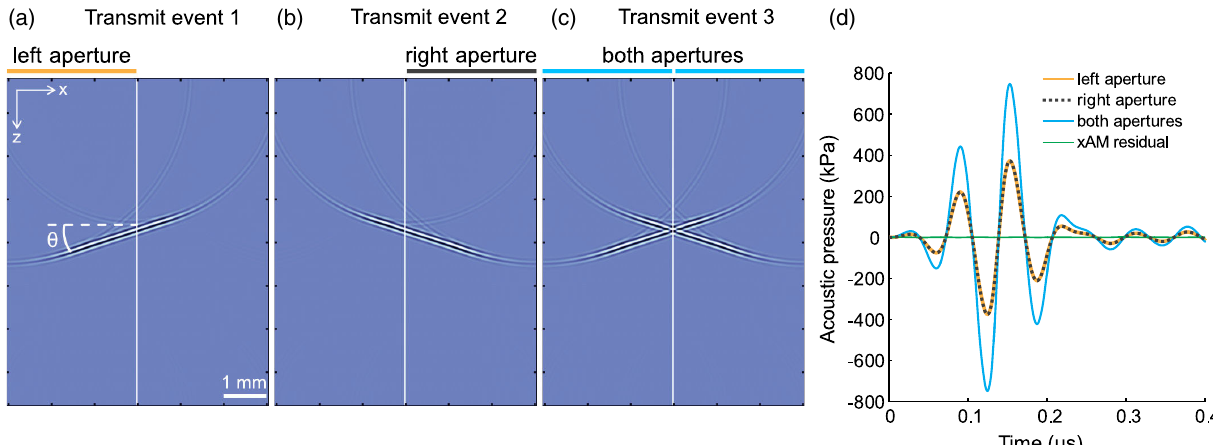
FIG. 2. Simulation of the xAM sequence for θ ¼ 18 ° in a homogeneous and isotropic water medium. (a) Half-aperture plane-wave transmission at an 18° angle with respect to the transducer array. (b) Axisymmetric half-aperture plane-wave transmission at an 18° angle with the other half of the array. (c) Cross-propagating plane-wave transmission at an 18° angle using both half-apertures. (d) Simulated waveforms at the bisector intersection for z ¼ 3 . 6 mm. The cross-propagating plane-wave peak positive pressure is 747 kPa (blue curve), while the residue peak positive pressure (green curve) is 0.13 kPa, or 0.02% of the cross-propagating plane-wave peak positive